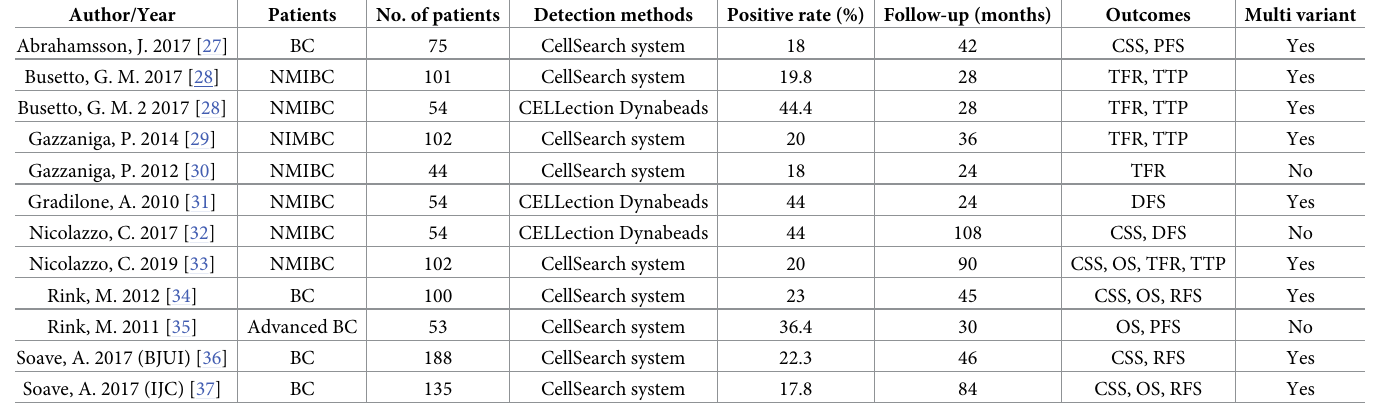
Table 1. Baseline characteristics of the included